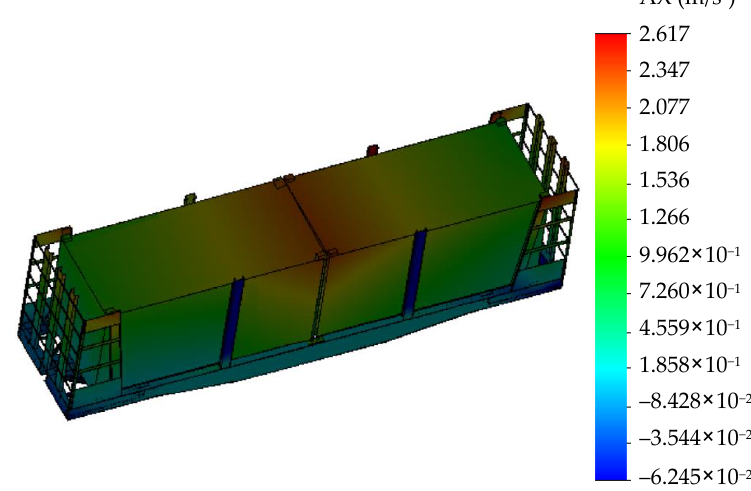
Figure 6. Design scheme of the load-bearing structure of the flat wagon with a container.